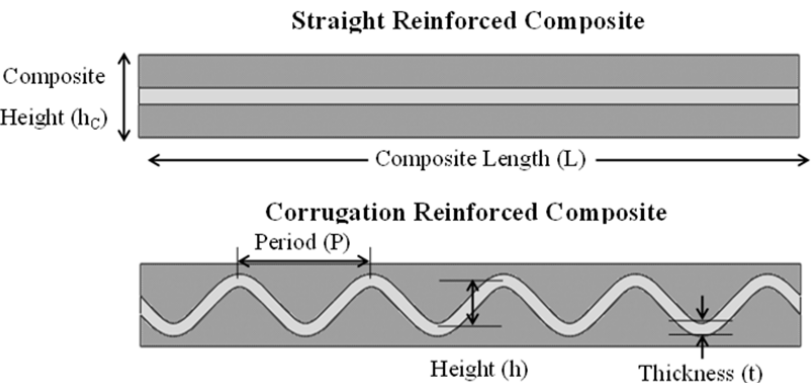
Figure 1. Depiction of straight reinforced composite (top) and corrugation reinforced composite (bottom) used in finite element modeling (FEM) simulations.